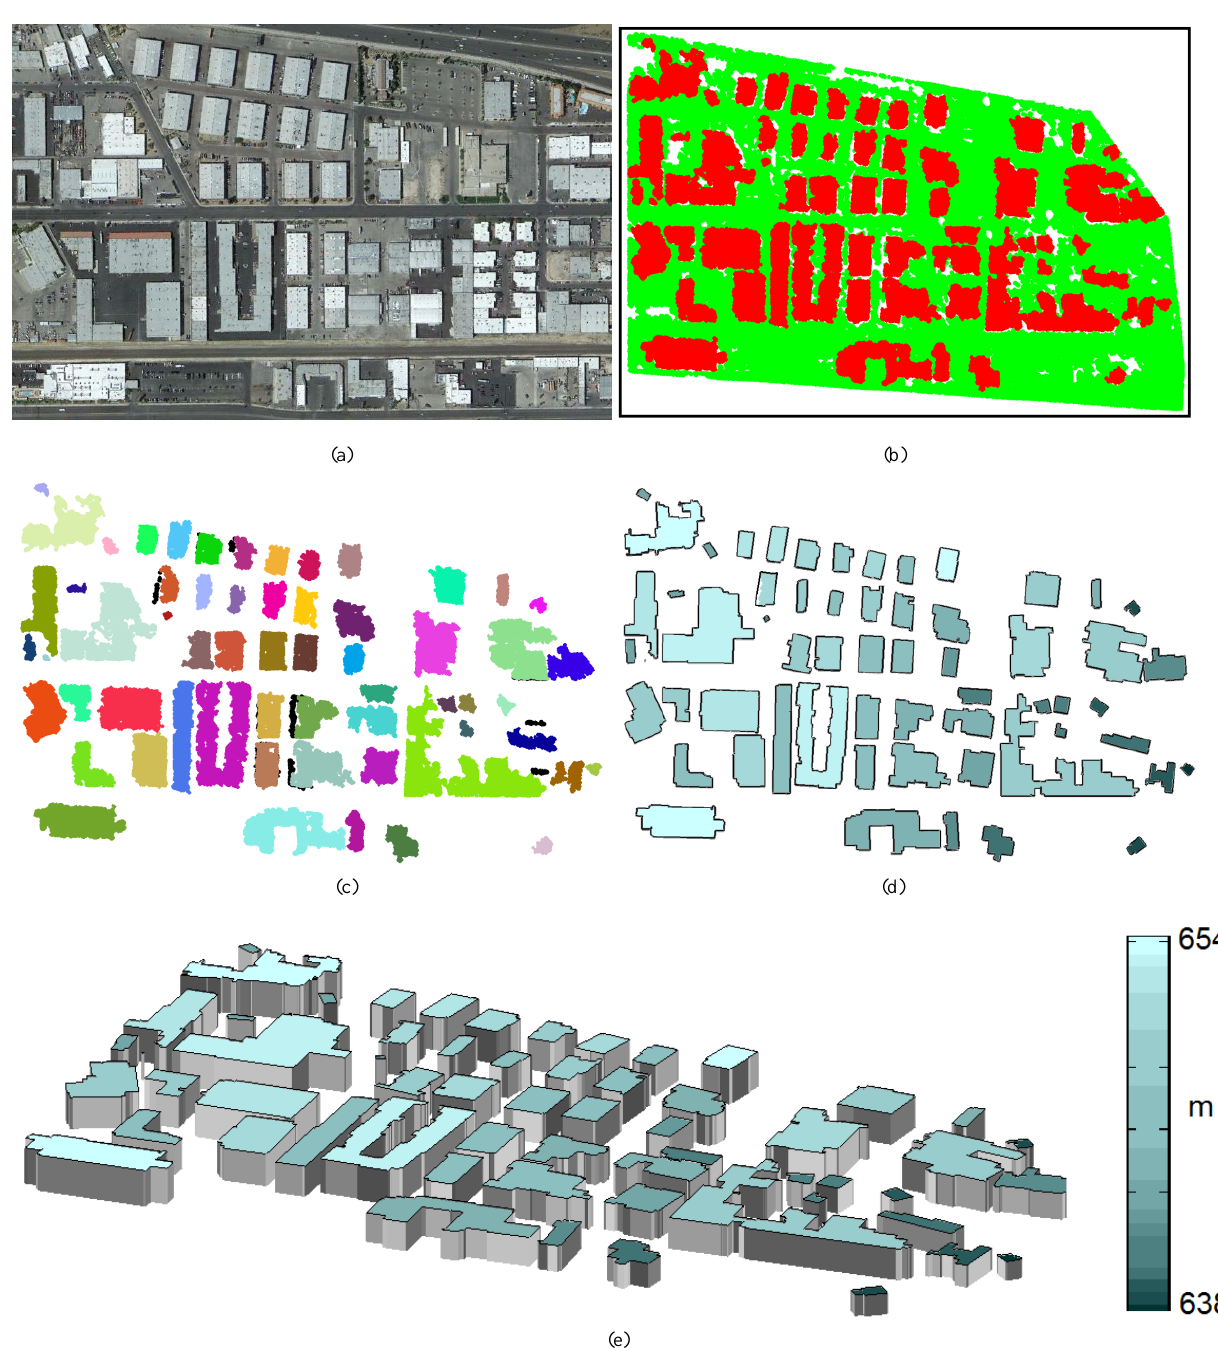
Figure 7: Results depicting complete reconstruction of building footprint: (a) Optical image of the Testsite 2 containing moderate sized buildings in the city of Las Vegas © Google Earth; (b) Results of building extraction. Red points are the extracted building roof points where as green points are non building points; (c) Segmentation results of the extracted roof points by applying spatial clustering. Black points are the extracted façade points that are first reconstructed and later incorporated along with the roof points to determine the overall shape of the building footprint; (d) and (e) shows the final reconstructed building footprint in 2-D and 3-D respectively. Also (d) and (e) share the same height colorbar [unit: